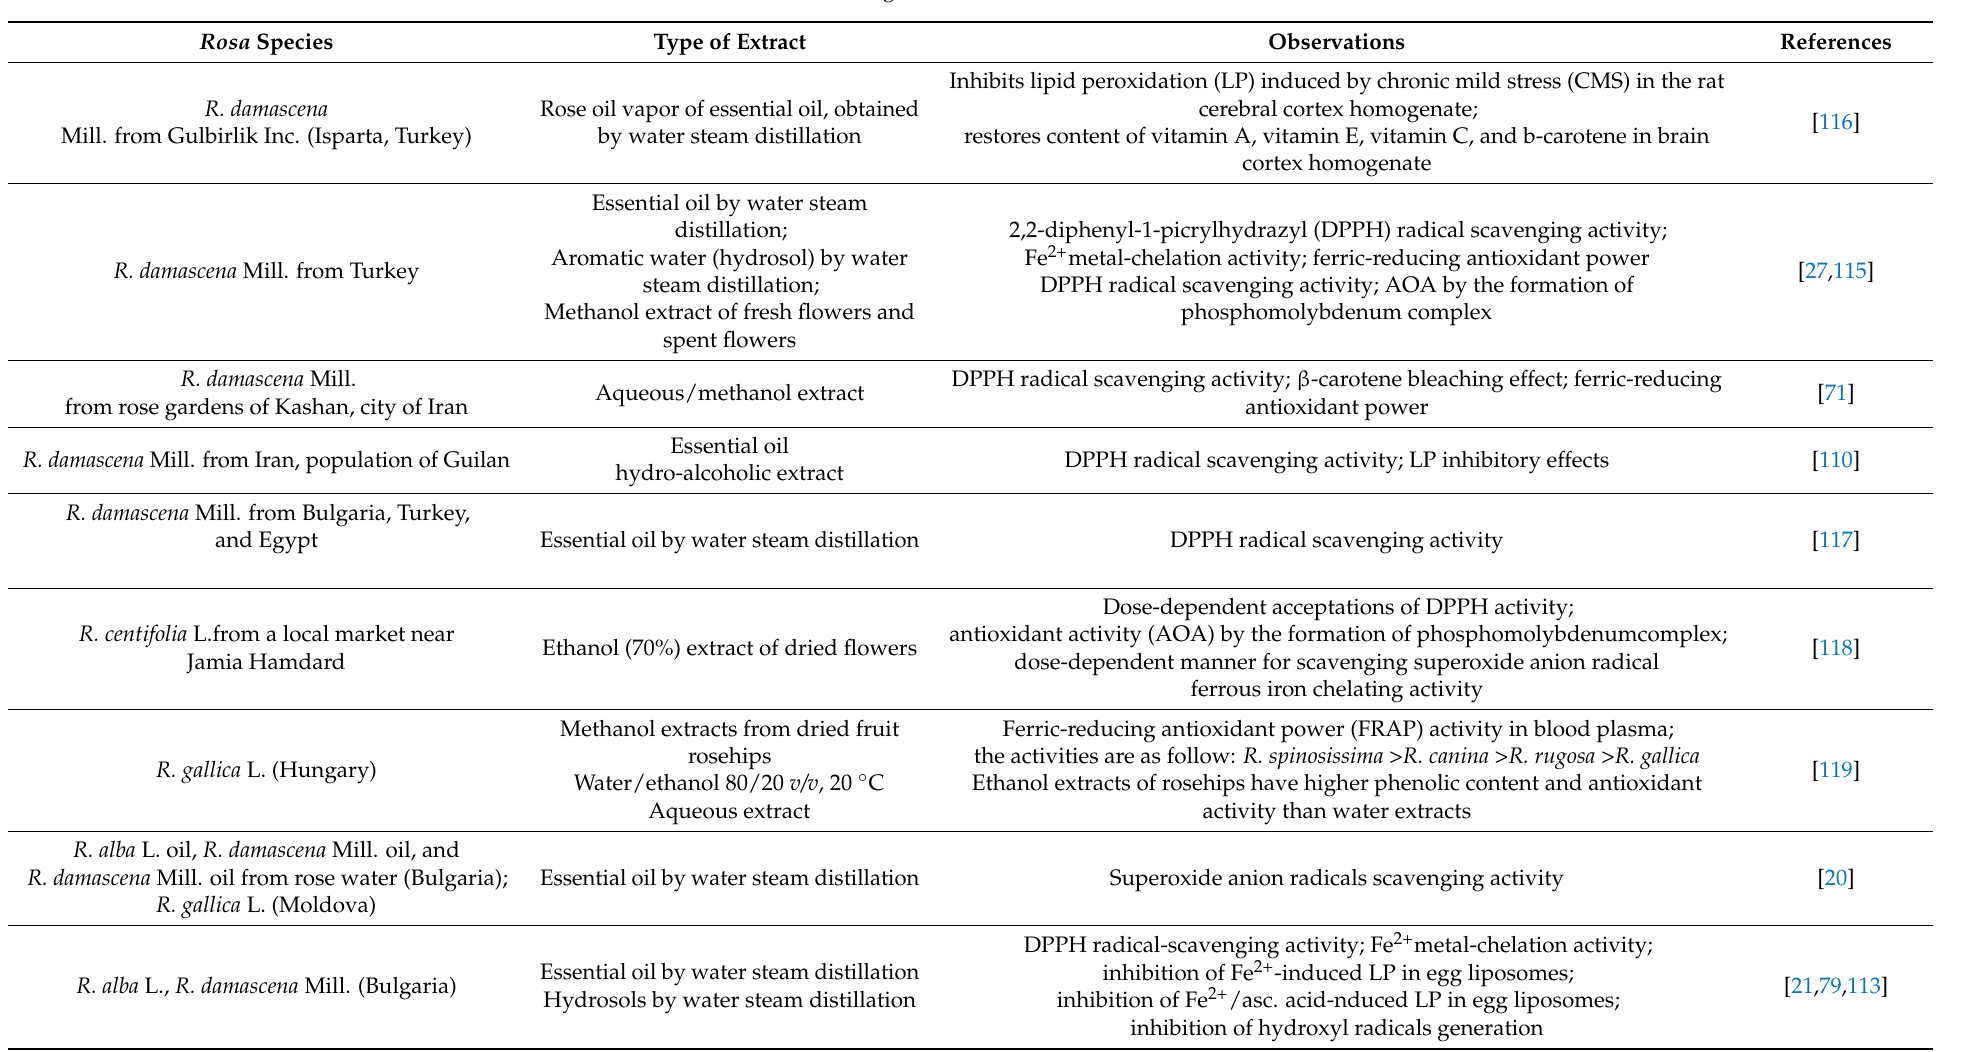
Table 4. Free radical scavenger and antioxidant activities of rose